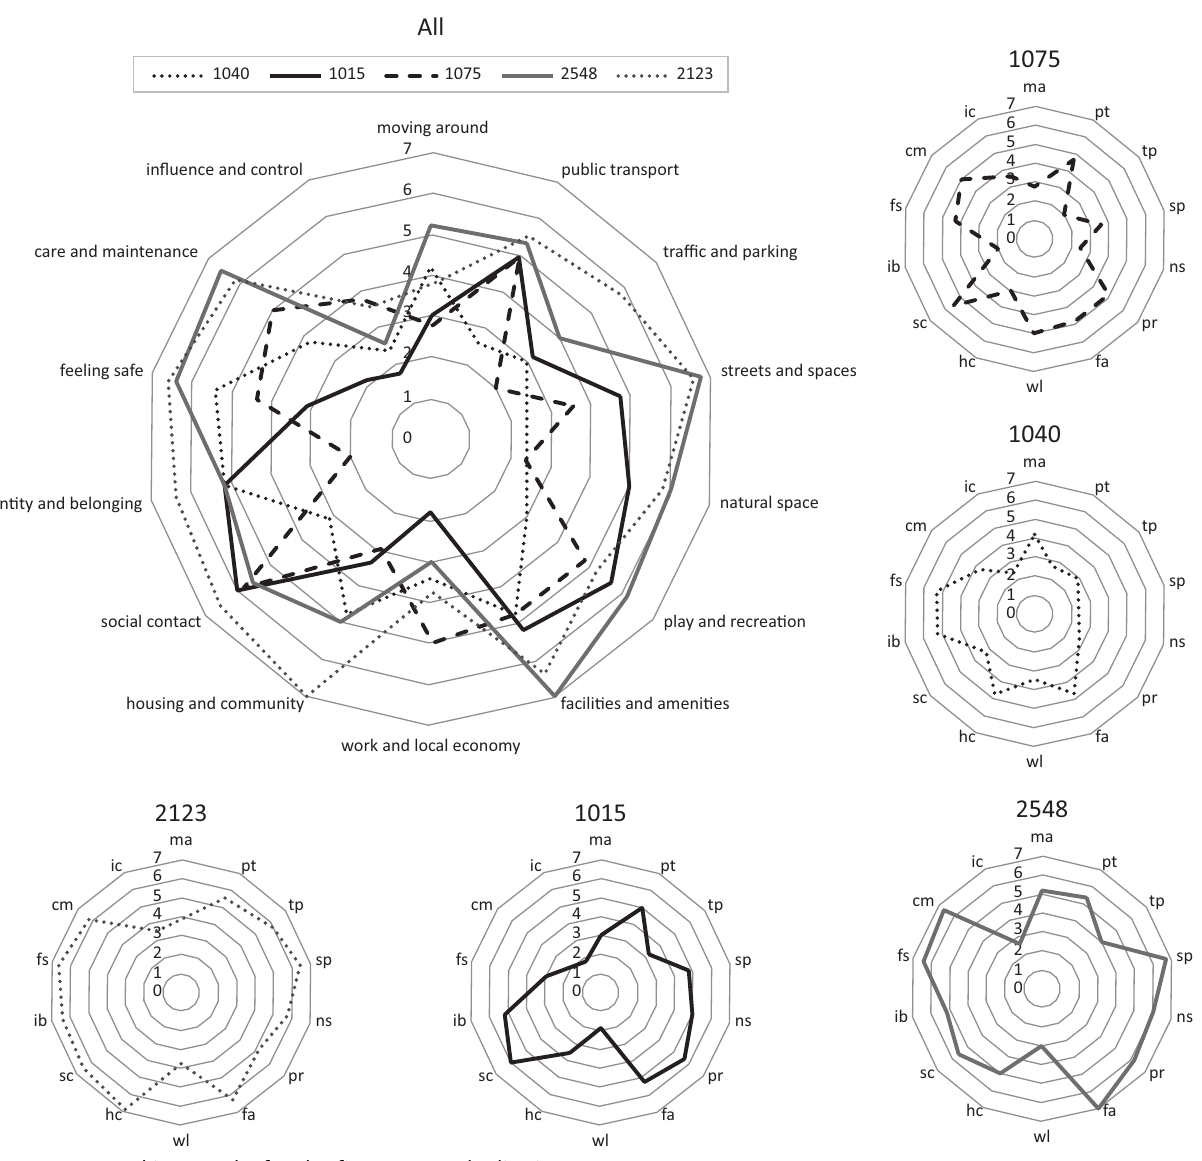
Figure 3. PS marking graphs for the five case study